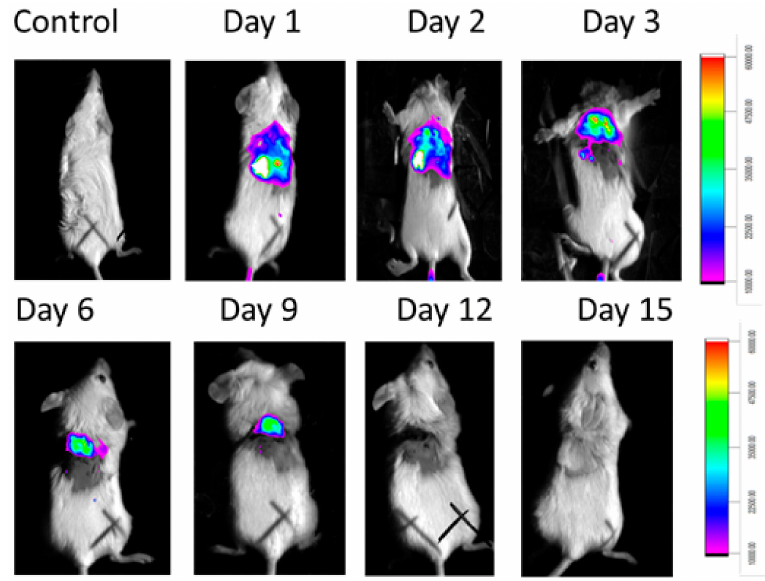
Figure 11. In vivo experiment where MMP Sense fluoresces in infected mice not in control and with time intervals the fluorescence disappears due to the